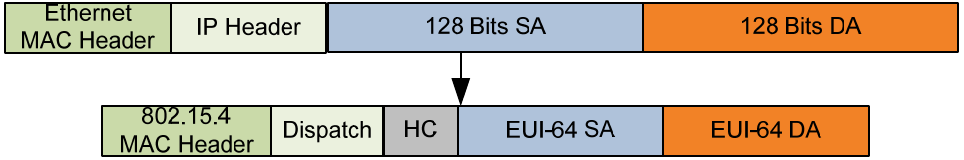
Figure 10. Communication from CN to